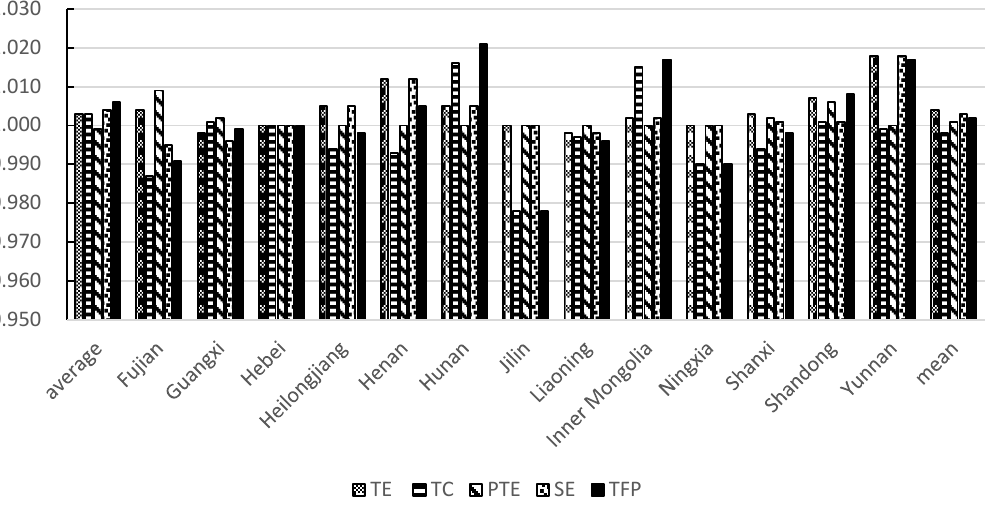
Figure 2. Efficiency changes in small-scale raw milk production areas in China from 2004 to 2020.